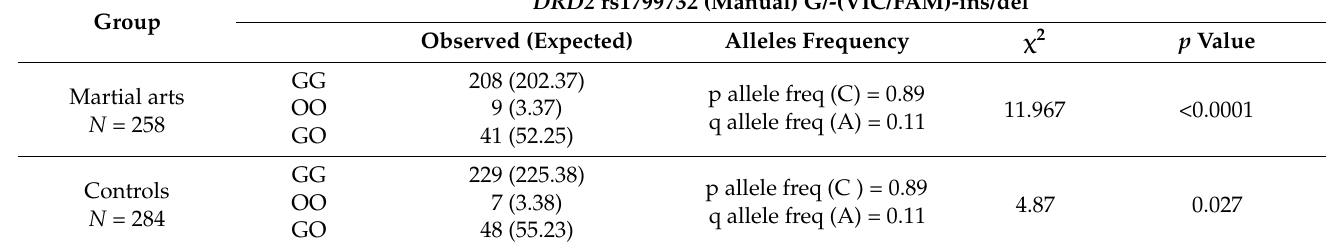
Table 1. Hardy–Weinberg equilibrium of the DRD2 rs1799732 (manual) G/ − (VIC/FAM) -ins/del in the group of martial arts subjects and controls.